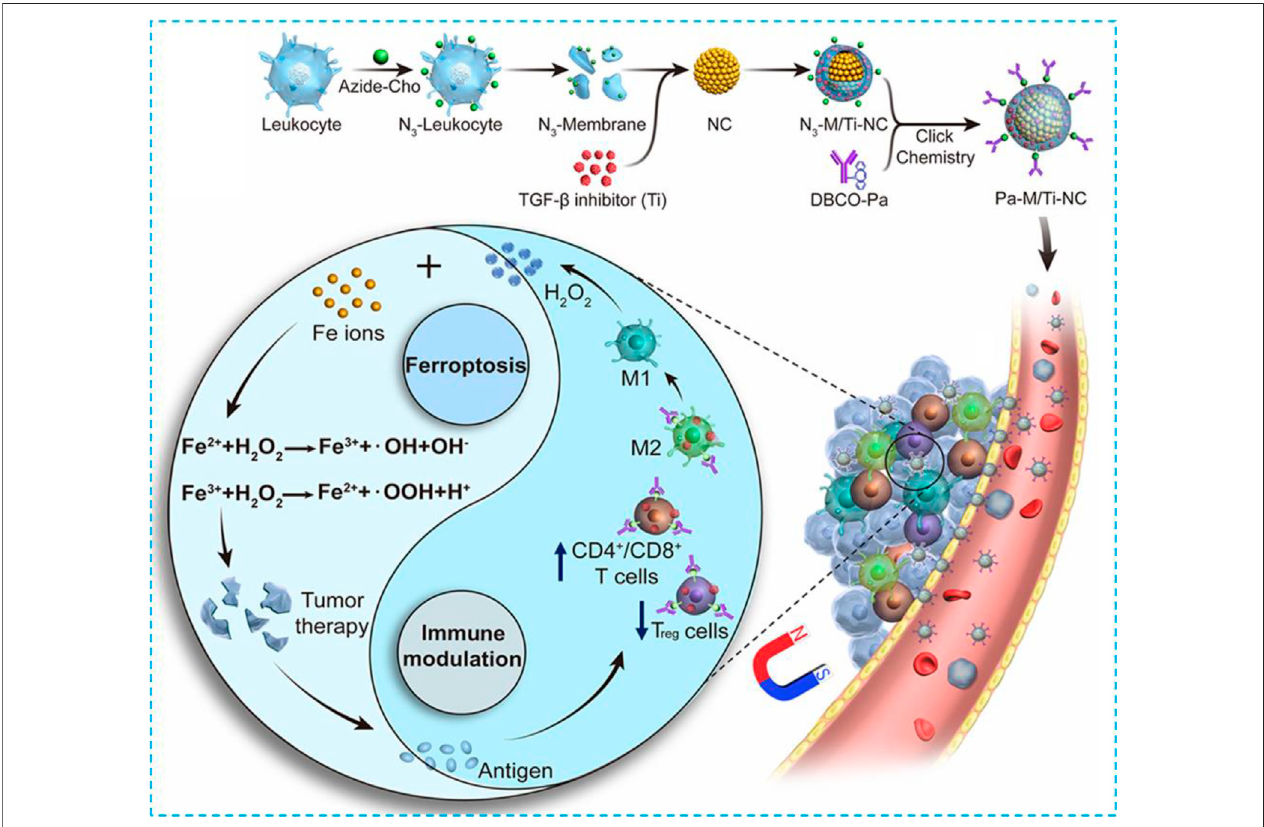
FIGURE 2 | Schematic illustration of the NMNP-CFZ nanoplatform for ferroptosis/immunomodulation synergism in cancer. Reprinted with permission from Ref. (Lyu et al., 2020) Copyright 2019 American Chemical Society.